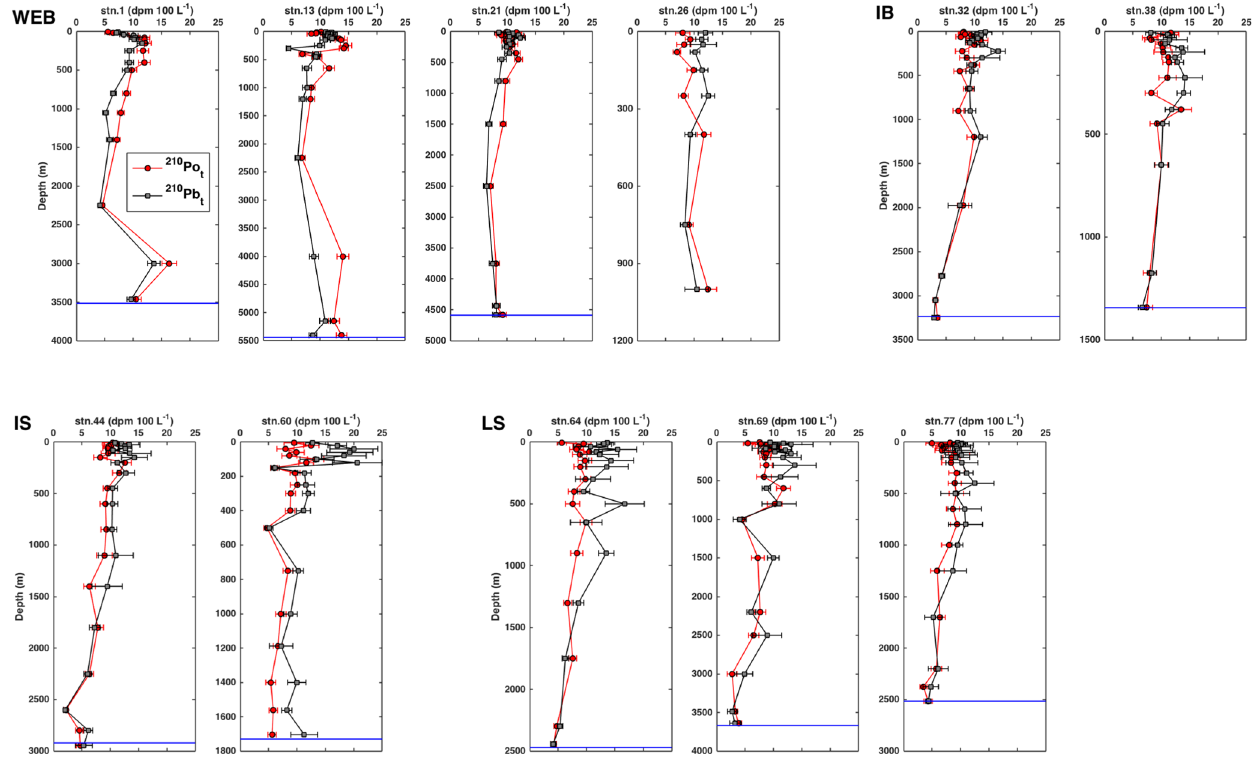
Figure 2. The depth profiles of total 210 Po ( 210 Po t , red circles) and 210 Pb activities ( 210 Pb t , grey squares) along the GEOVIDE section. The horizontal blue line is the bottom depth, which coincided with the deepest water sample except for station 26, which was sampled only down to 1000m. Note that the depth scale for each plot may be different. The profiles are shown in the order of sampling date with the region indicated on the top left: West European Basin (WEB), Iceland Basin (IB), Irminger Sea (IS), Labrador Sea